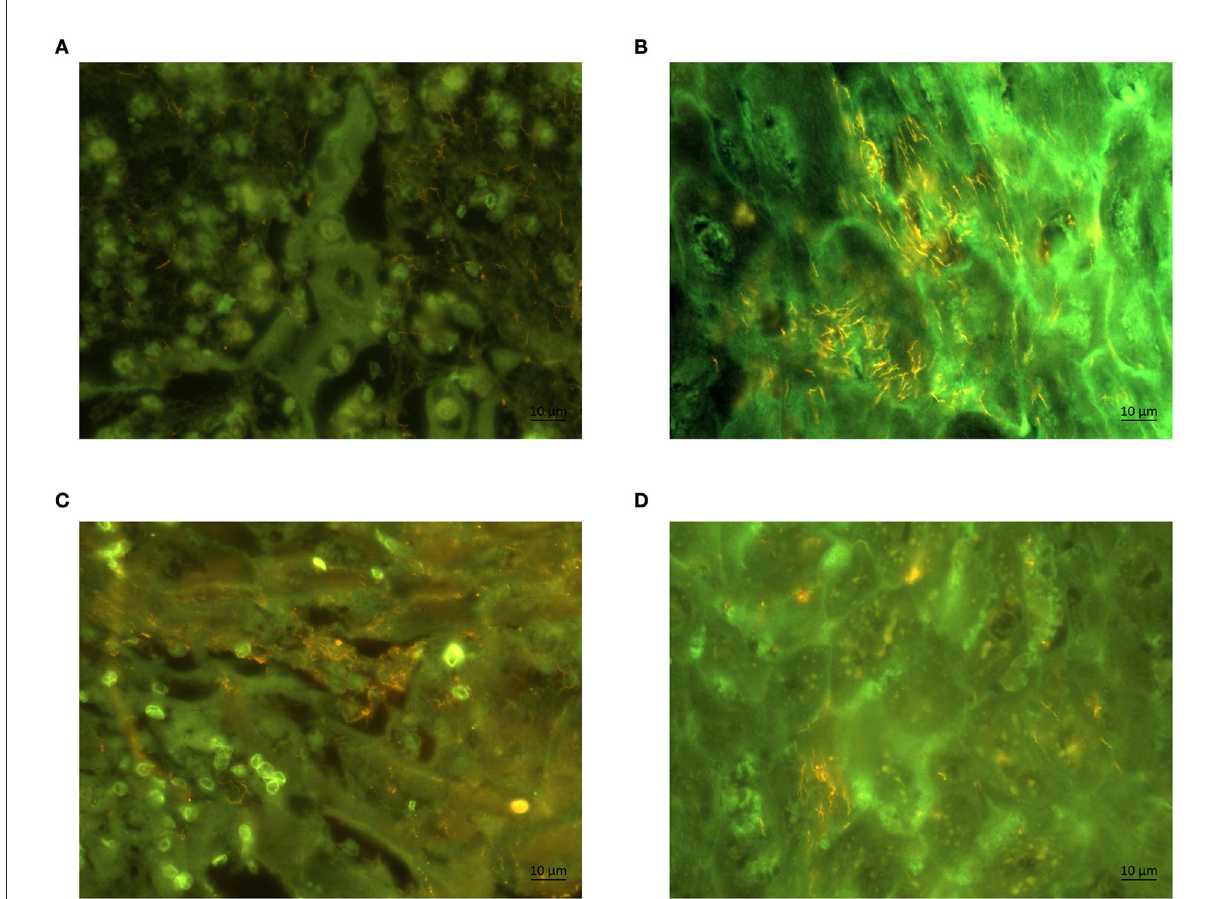
FIGURE3 Fluorescent in situ hybridization of biopsies of a ram (A) and a ewe (B) with probes for genus Treponema (Cy3 labeled). Section of the same biopsy hybridized with (Cy3 labeled) species specific oligonucleotide probe for Treponema phylotype PT1 in a ram (C) and ewe (D) . The Treponema organisms appear yellow; magnification (60 ×